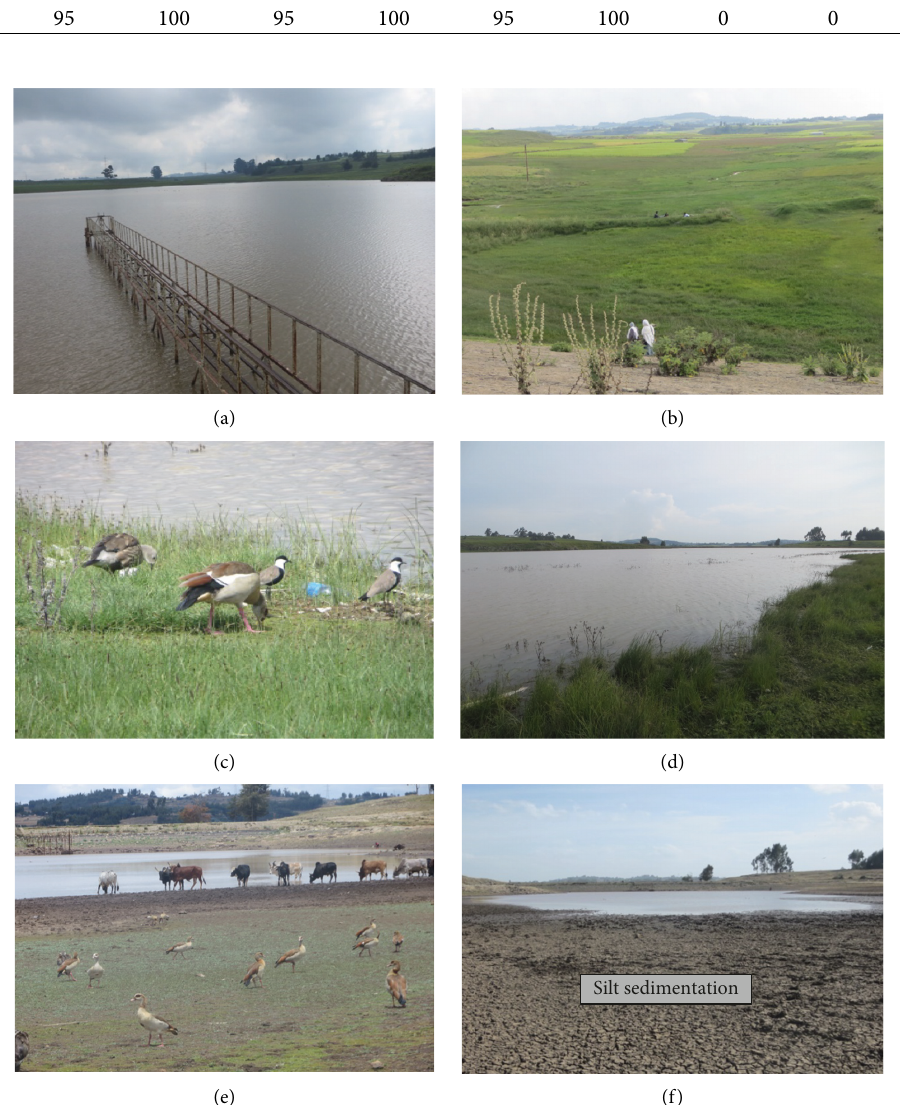
Figure 3: Partial views of Washa site during wet (a, b, c, d) and dry (e, f) seasons with the reservoir filled fully with water (a, c, d), downstream wetlands (b), surrounding wetlands with herbaceous species and birds (c–d), and cattle watering with some birds (e) and high water reduction and silt sedimentation (f), where the photos were taken at the end of the rainy season (September 2020) and in the dry season (May